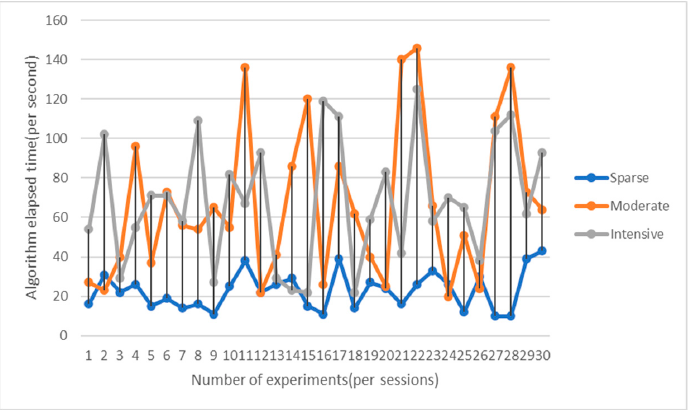
Figure 25. Comparison of consumption of time in each scenario with the AV-RRT algorithm.